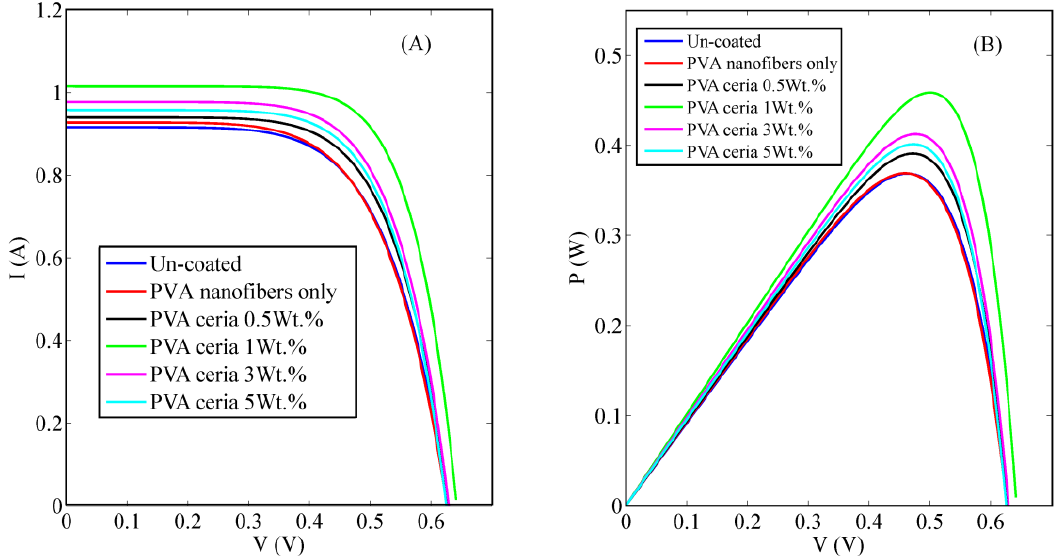
Figure 6. Comparison between uncoated and different concentrations of electrospun ceria nanoparticles embedded in PVA nanofibers coating solar cells ( A ) I–V curve; ( B ) P–V curve.